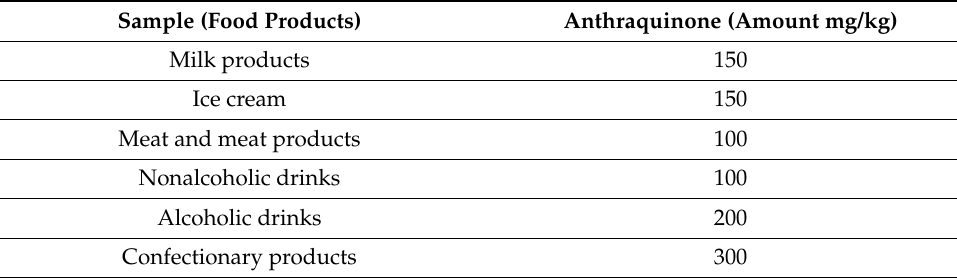
Table 3. Use of anthraquinone (Arpink red) pigment in various food